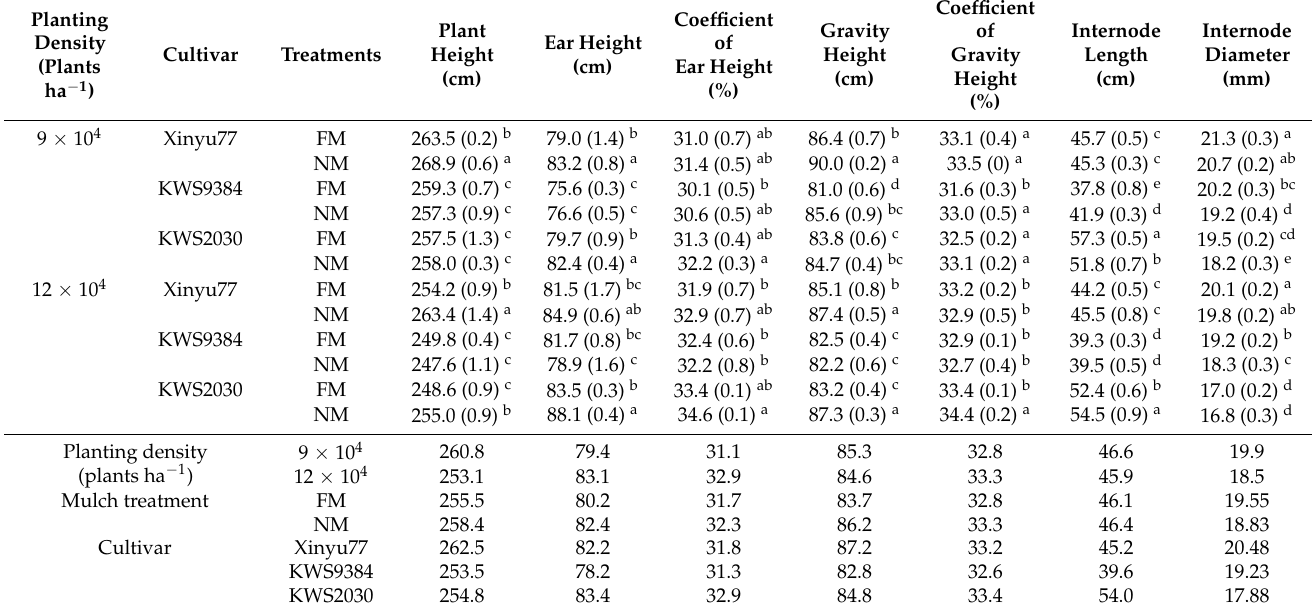
Table 1. Differences of maize plant morphology and basal internode morphology between film mulch (FM) and no-film (NM) planting.